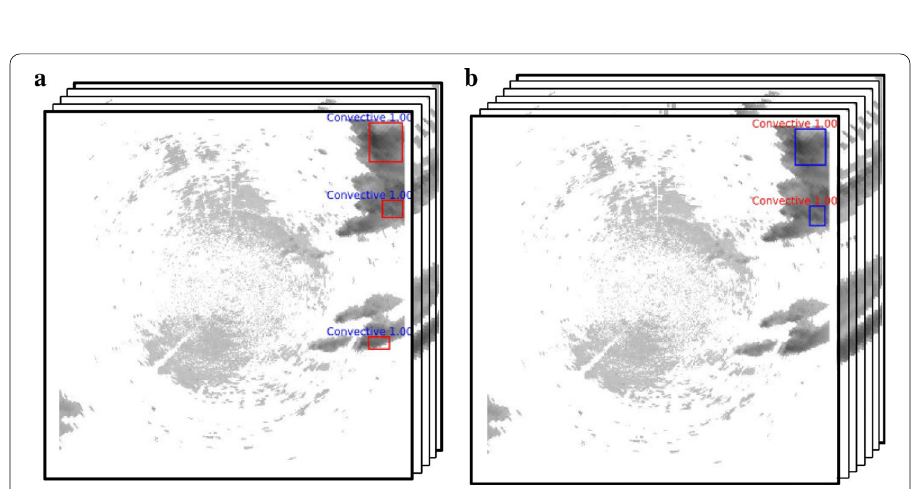
Fig. 13 The identification result of precipitation clouds corresponding to 2342UTC. a FR-Z, b